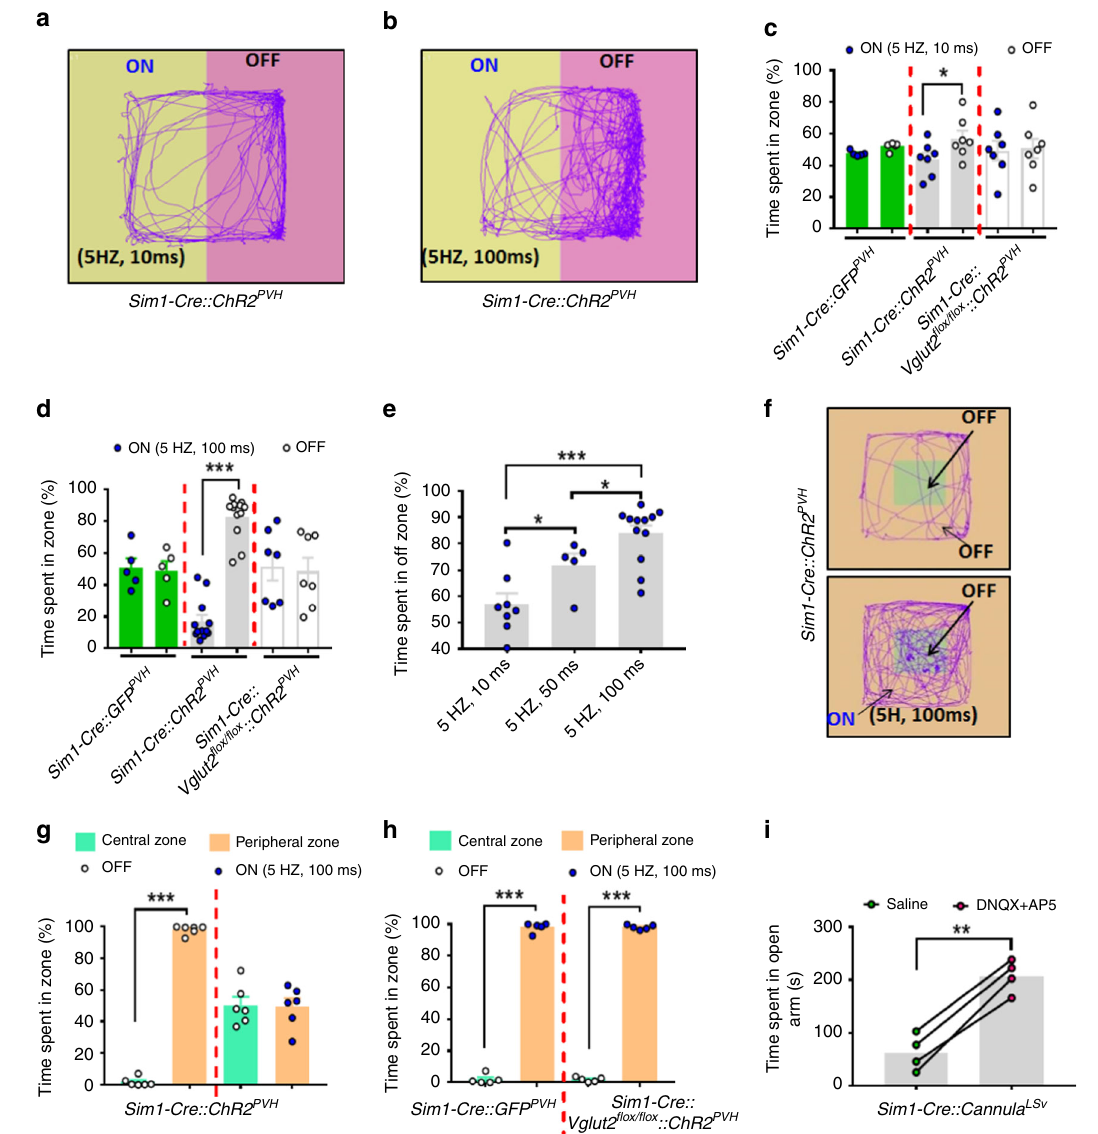
Fig. 4 Photostimulation of PVH → LSv terminals produces negative valence. a – e Real time place preference were conducted in male mice with photostimulation of PVH → LSv fi bers. A representative mouse locomotion trace was shown with short a and long b pulse photostimulation in Sim1-Cre mice. Time spent during laser on (ON) and off zones (OFF) in Sim1-Cre and Sim1-Cre::Vglut2 fl ox/ fl ox mice with AAV-Flex-ChR2-eGFP delivery, or Sim1-Cre mice with AAV-Flex-GFP delivery using the short pulse ( c , Sim1-Cre::ChR2 PVH mice n = 7, p = 0.0321) and the long pulse stimulation ( d , Sim1-Cre::ChR2 PVH mice n = 12, p < 0.0001). e Time spent in OFF zone shows dependence on the photostimulation duration with fi xed 5 Hz and 5 mW/mm 2 light ( n = 5; 5 HZ,10 ms vs 5 HZ,50 ms, p = 0.0452; 5 HZ,50 ms vs 5 HZ,100 ms, p = 0.0356; 5 HZ,10 ms vs 5 HZ,50 ms, p < 0.0001). f – h Mice described in a – e were tested in a modi fi ed RTPP, in which photostimulation was paired with the periphery of the arena ( f , uncolored area). Representative movement traces were shown with no pairing ( f , upper) or pairing ( f , bottom), time spent in zones with laser on or off from mice with the indicated genotypes ( g and h , n = 6, p < 0.0001). i Time spent in open arms during elevated plus maze tests in mice with local infusion of glutamate receptor antagonists DNQX/AP5 to the LSv ( n = 4, p = 0.0012). n = 4 – 12. * p < 0.05, *** p < 0.001, two-way AVONA tests ( c , d and g , h ), One-way AVONA tests e or paired student ’ s t tests